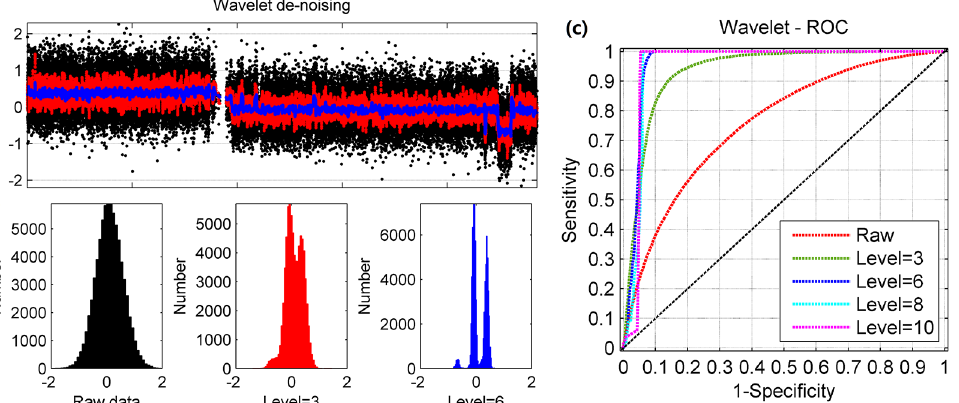
Fig 3. Assessment of wavelet de-noising on LRR signals. Assessment of performance of wavelet de-noising. (a) Comparison between raw LRR signals and recovered signals with decomposition level of 3 and 6. (b) Histograms of raw LRR signals and recovered signals with decomposition level of 3 and 6. (c) Assessment of quality improvement using ROC curves for recovered signals associated with decomposition level 3, 6, 8 and 10.